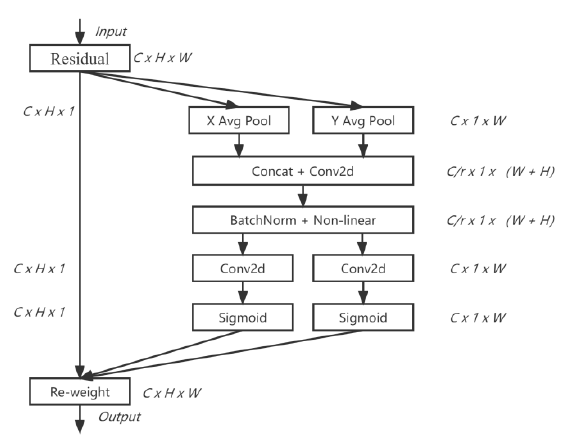
Figure 5. Coordinate attention.